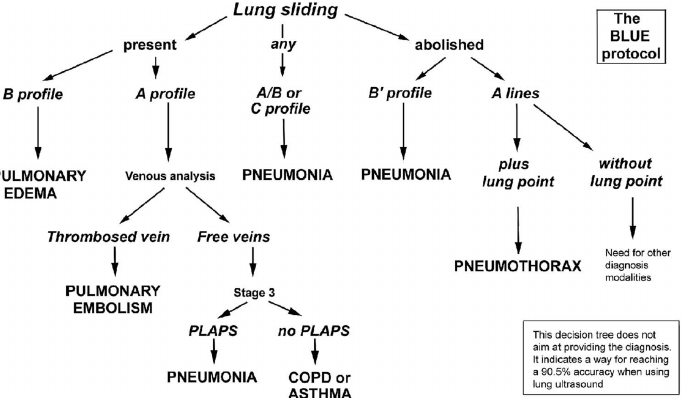
Figure 1. A decision tree utilizing lung ultrasonography to guide diagnosis of severe dyspnea (Adapted with permission [13]).